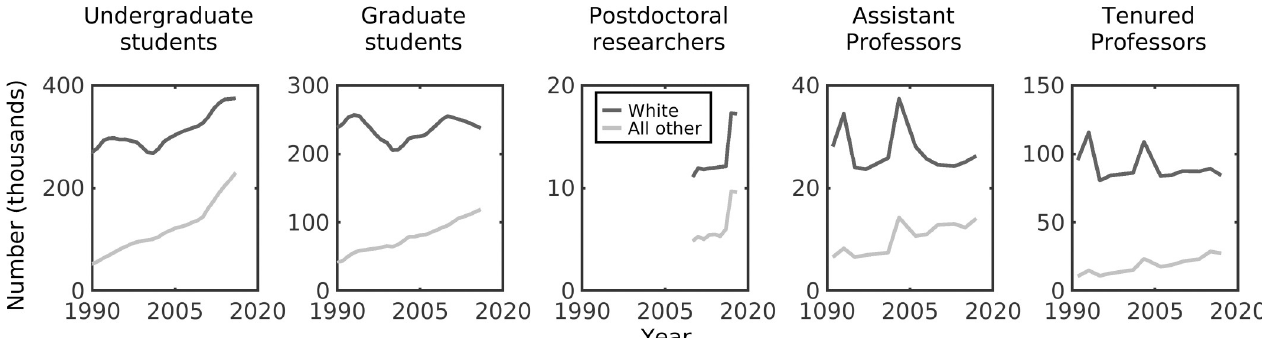
Fig 3. Number of scholars over time. The absolute number (in thousands) of scholars that are White (solid black line) and all other races/ethnicities (solid grey line) in each stage (panel) over time.